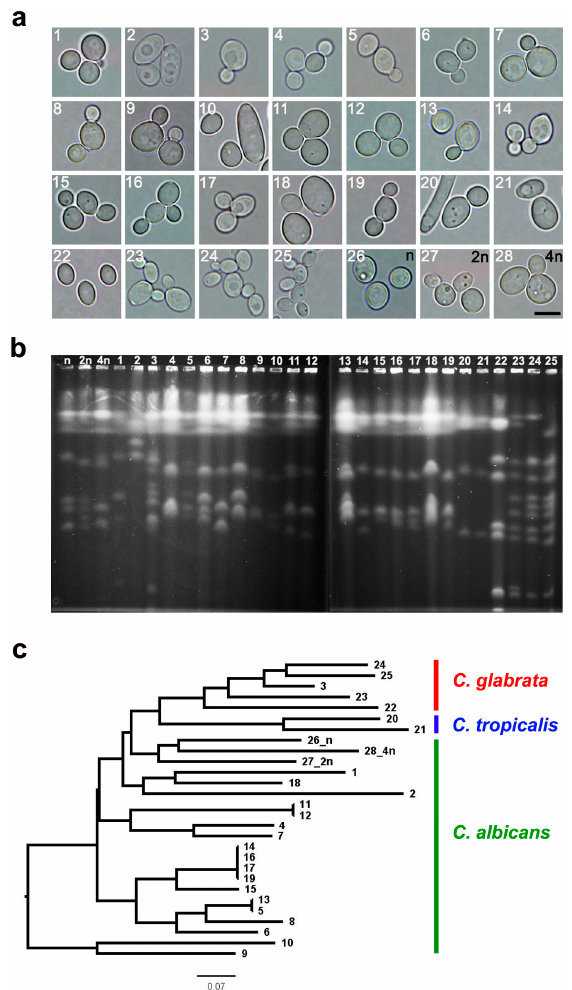
Figure 1. Cell morphology ( a ) and electrophoretic karyotyping ( b , c ) of 25 clinical Candida isolates and three reference strains (haploid, diploid, and tetraploid). ( a ) Representative microphotographs are shown. Scale bar 5 µm, objective 100×. ( b ) Representative karyotype patterns are shown. ( c ) The dendrogram of chromosome band-based similarity. C. albicans group (1, 2, and 4–19), C. tropicalis group (20, 21), C. glabrata group (3 and 22–25), 302 haploid reference strain (26), SC5314 diploid strain (27), and T15 tetraploid strain (28).